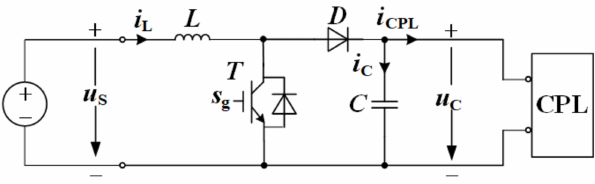
Figure 3. Power Circuit of Boost Converter with CPL.